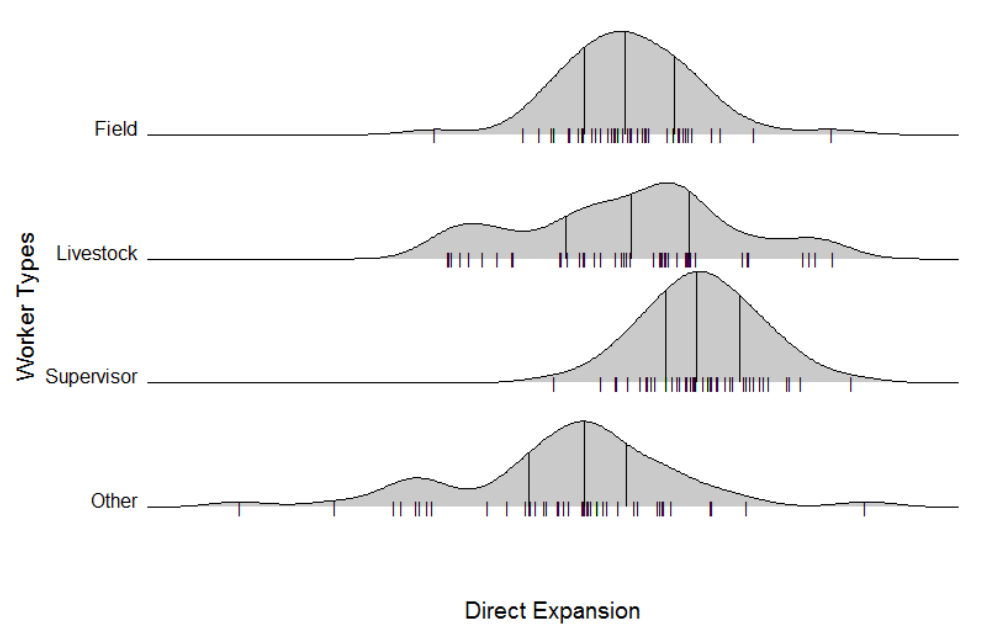
Figure 3. Density plots of the original January 2020 state-level survey estimates of hours per week by each worker type: field workers, livestock workers, supervisors, and other types of workers.